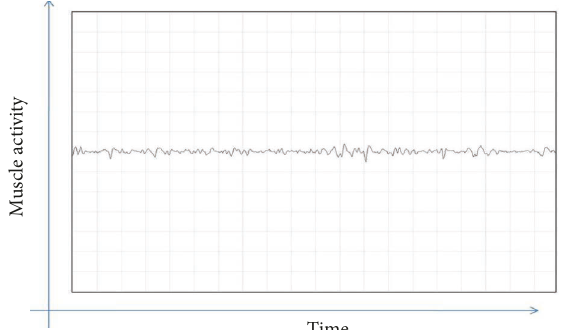
Figure 2: Electromyography recording of a healthy individual after treatment.